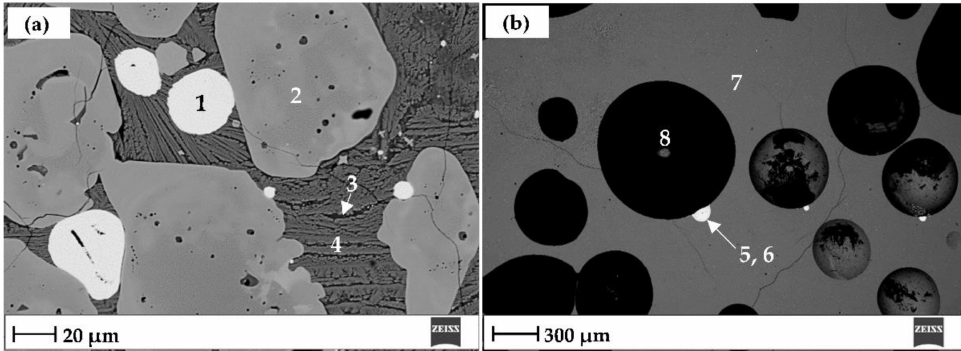
Figure 6. ( a ) SEM image of slag from level 1 in batch T1 at the settling end where “1” is matte, “2” the chromium spinel, and “3” and “4” the slag phase; ( b ) SEM image of slag from level 5 in batch T4 at the settling start, where “6” is matte surrounding speiss, “5”, in the bright droplet. “7” is the slag phase and “8” is a pore caused by a gas